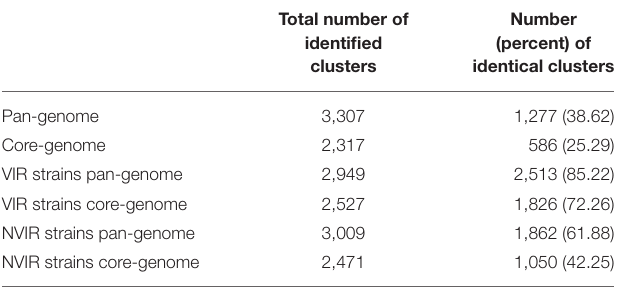
TABLE 1 | Number of clusters gathering open reading frames exhibiting over 90% protein sequence similarity in the studied group of S. aureus